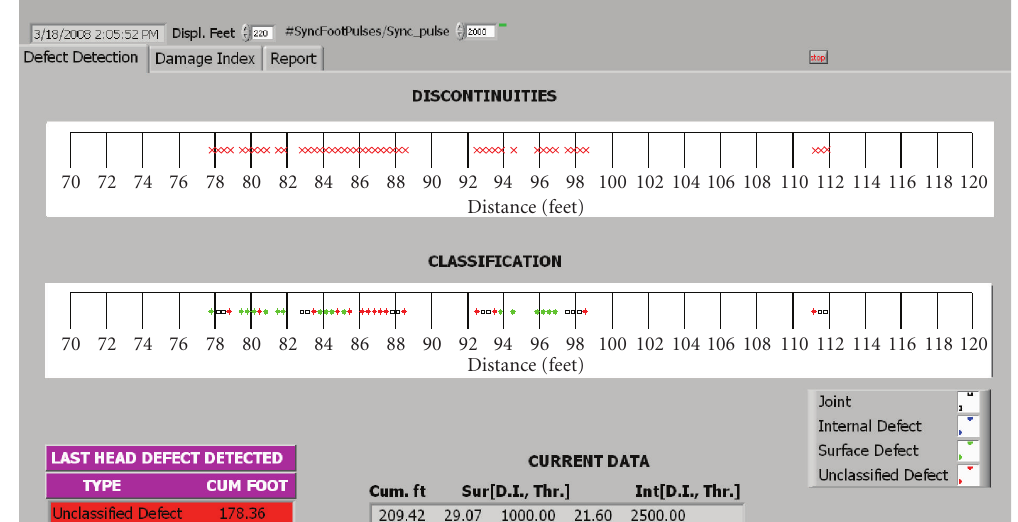
Figure 12: The “Defect Detection” window of the user’s interface showing the real-time classification of joints and defects as color-coded